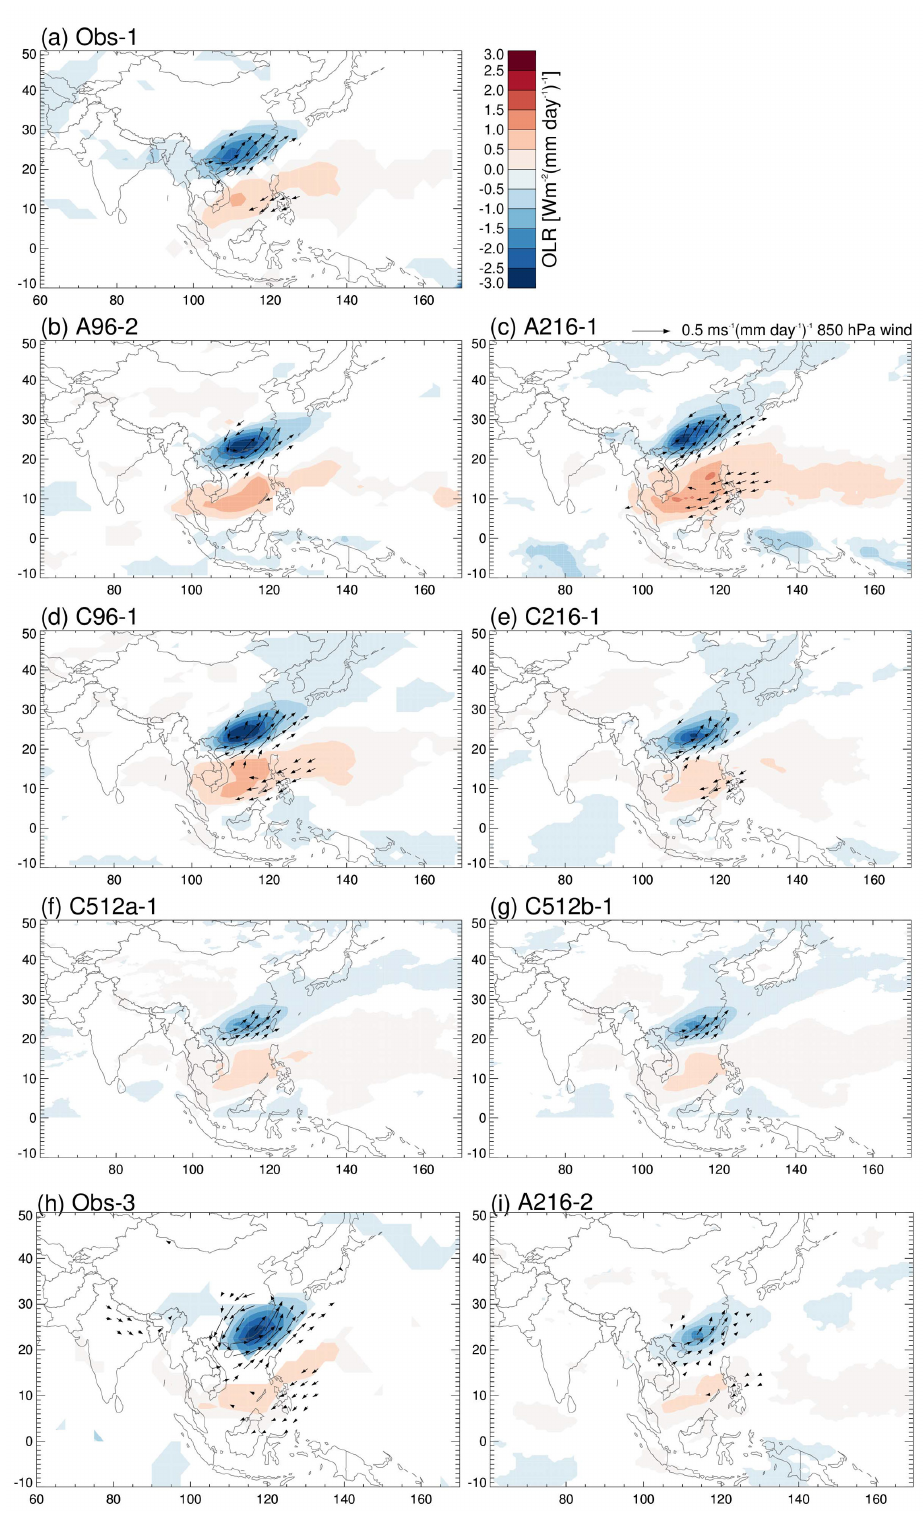
Figure 9. Regressions of OLR (shading) and 850hPa wind (arrows) against MJJASO time series associated with Obs-1 (a–g) and Obs-3 (h– i) . All shown values are significant at the 10% level. Wind arrows are drawn where one component is statistically significant and the speed exceeds 0.1ms − 1 (mmday − 1 ) − 1 (a–g) or 0.04ms − 1 (mmday − 1 ) − 1 (h–i)